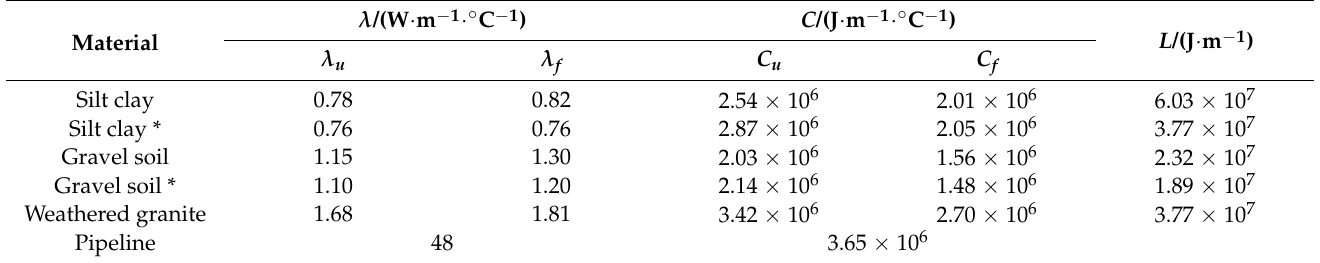
Table 2. Thermal physical parameters of soils and pipeline used for the proposed model.